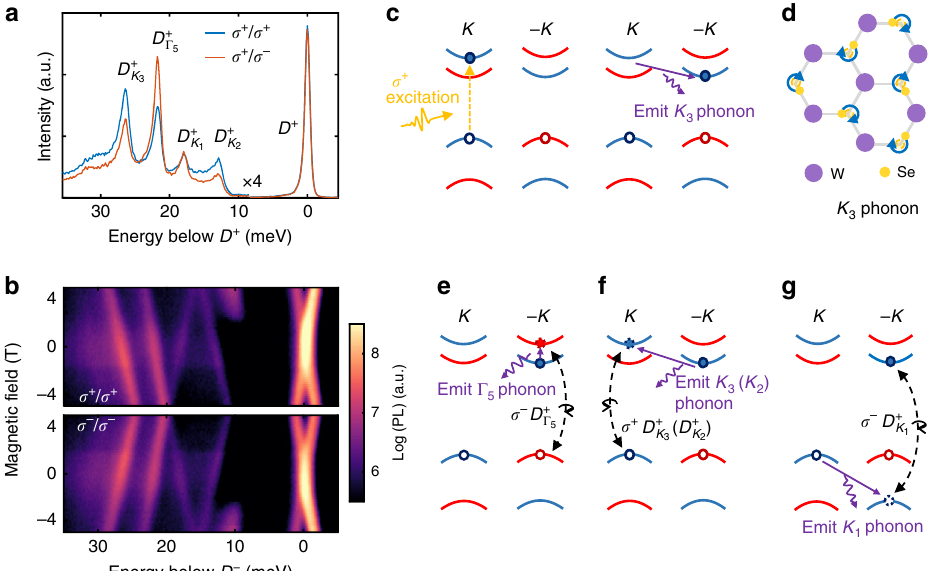
Fig. 2 Valley phonon replicas of positively charged dark trion. a Circular polarization resolved PL of the quadruplet PL peaks on the hole doping side. The photon energy of the spectrum is offset with respect to the positively charged dark trion ( D + ). The intensity of the quadruplets is multiplied by a factor 4 to emphasize the weak spetrum features. b Circular polarization resolved magneto PL of the quadruplets with σ + / σ + (top) and σ − / σ − (bottom) excitation/ detection. c Schematic of D + formation process under σ + excitation. Blue and red represent bands with electron having spin up and down, respectively. Filled and un fi lled circles represent electron and missing electron (hole) in the conduction and valence band, respectively. Orange dashed line indicates photo excitation. Purple arrow denotes the emission of valley phonon. d Illustration of vibrational normal mode of K 3 phonon, wherein Se atoms orbit around their equilibrium positions. See Supplementary Fig. 6 for other valley phonons. e – g Schematic of phonon-assisted emission process of D þ Γ D þ D þ , and D þ phonon replicas, respectively. Dashed circle: virtual state. As indicated by the purple arrow, the optically dark state couples to the bright K 3 K 2 K 1 ones by emitting a valley phonon, resulting in a Stokes shift of the dark trion emission by the recombination of an electron – hole pair (black dashed line). See text for